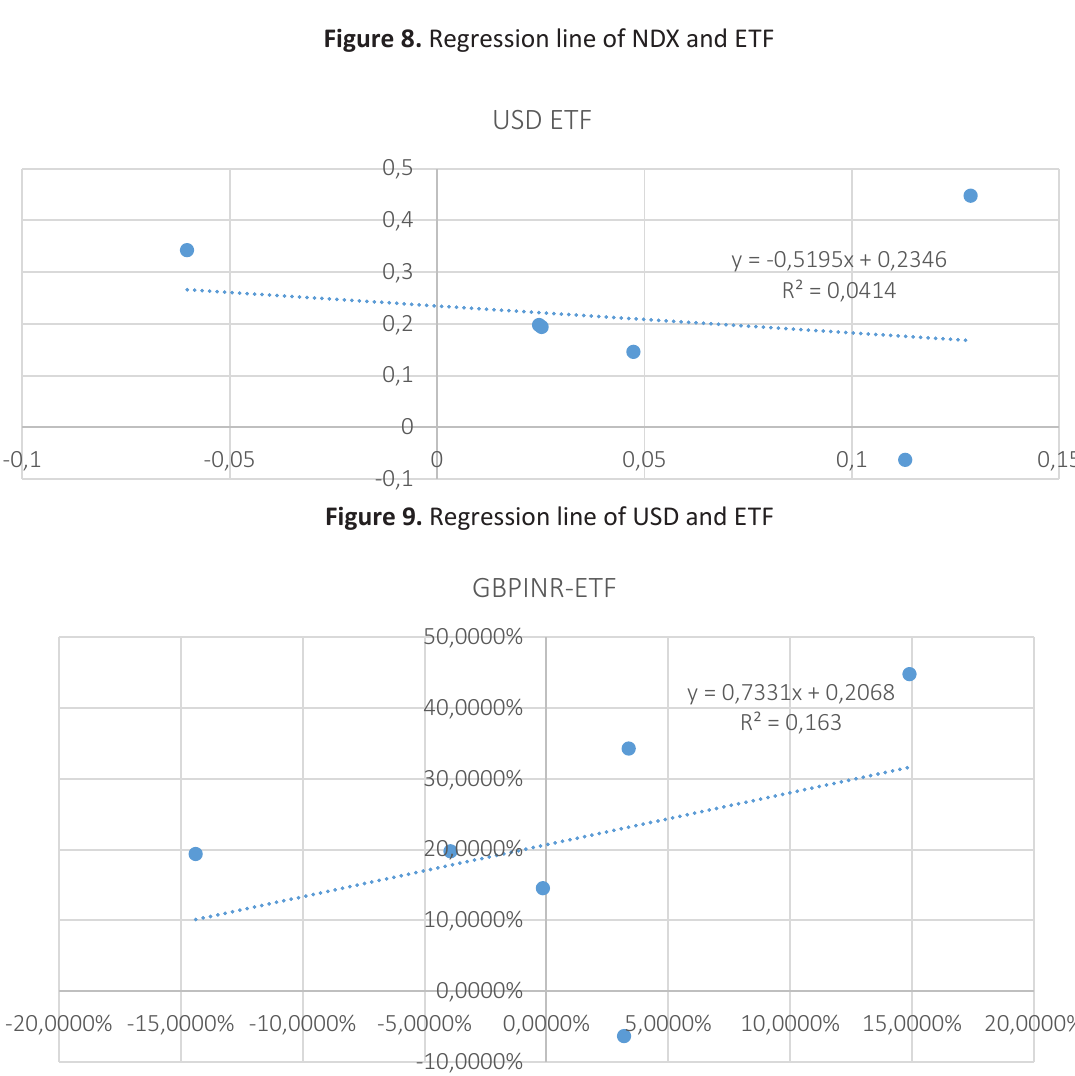
Figure 10. Regression line of GBPRM and NDX